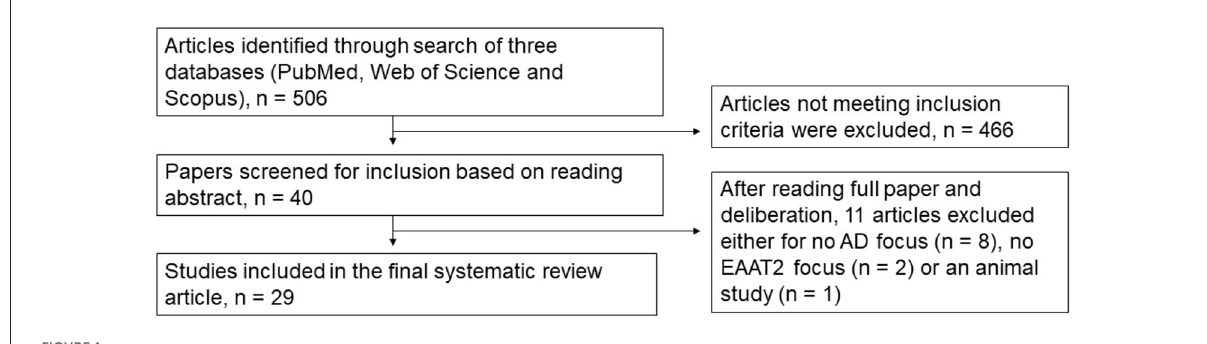
FIGURE1 Flow diagram detailing the article selection